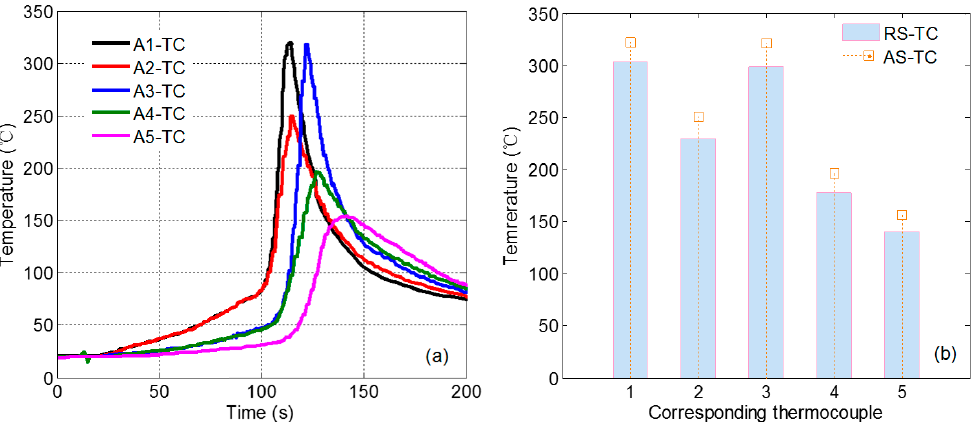
Figure 8. Monitoring data of workpiece temperature. ( a ) Temperature curve on the advancing side; ( b ) temperature comparison on the advancing side and the retreating side.